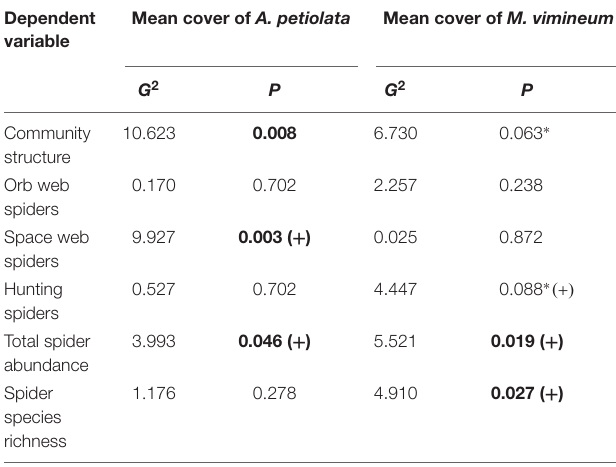
TABLE 2 | Correlations between spider community and invasive plant